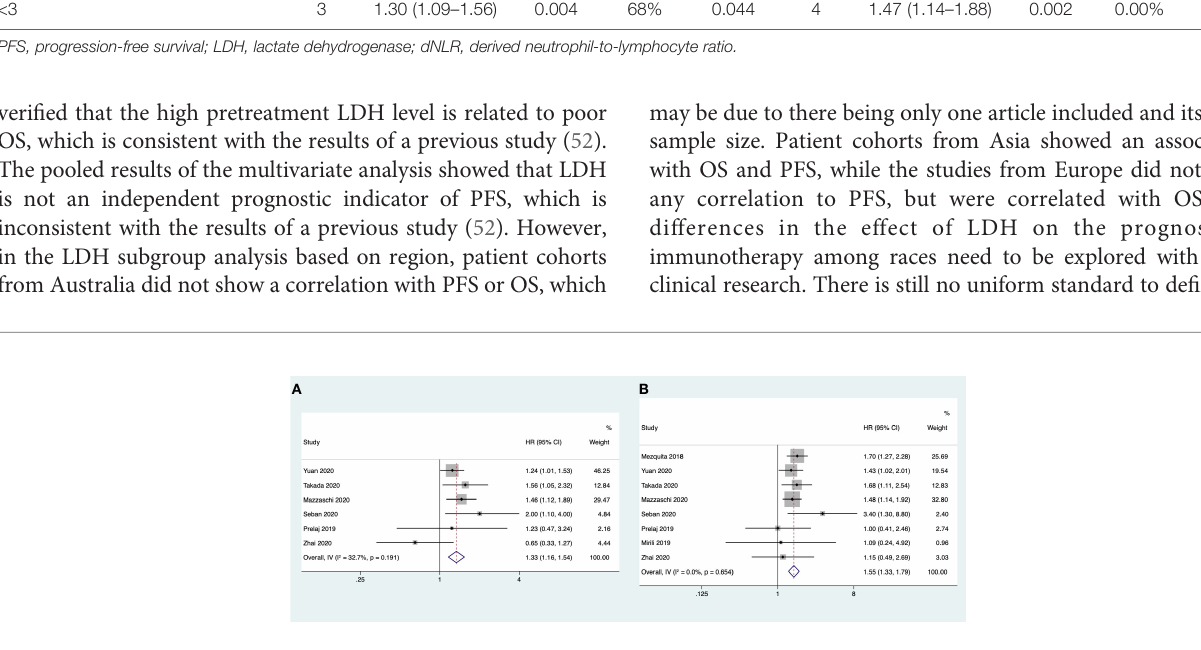
FIGURE 3 | (A) Forest plots of the association between pretreatment derived neutrophil-to-lymphocyte ratio (dNLR) and progression-free survival. (B) Forest plots of the association between pretreatment dNLR and overall